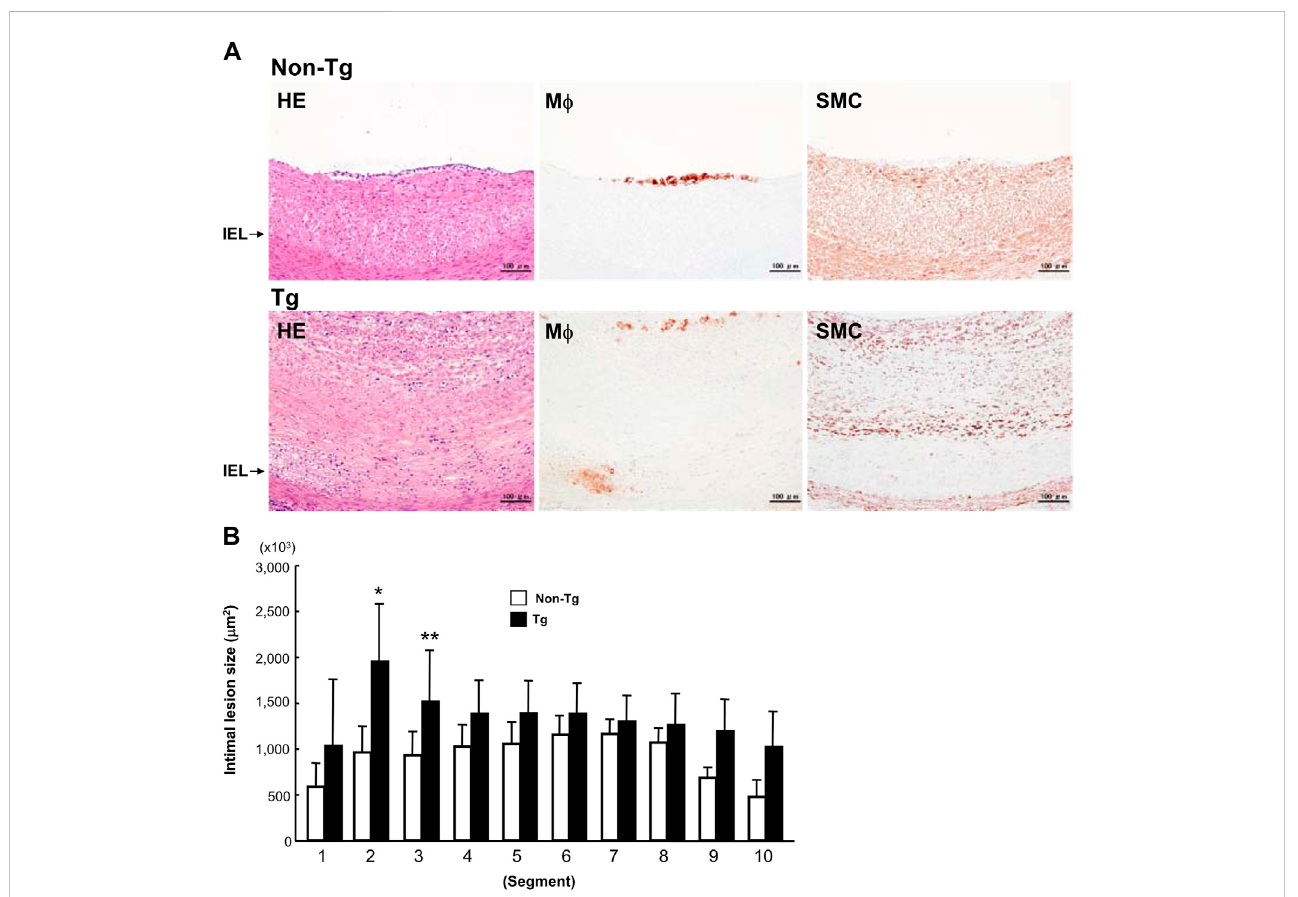
FIGURE 5 Representative intimal atherosclerotic lesions of Tg and non-Tg rabbits (A) and quantitation of intimal lesions (B) . A: Cross-sections of the aorta were stained with H&E or immunohistochemically stained with Abs against macrophages (M ϕ ) and smooth muscle cells (SMC). B: The area occupied by intimal lesions was measured using an image analysis system as described in the Materials and Methods. The data were expressed as the mean ± SE ( n = 12 for each group). * p < .05, ** p < .01 vs.